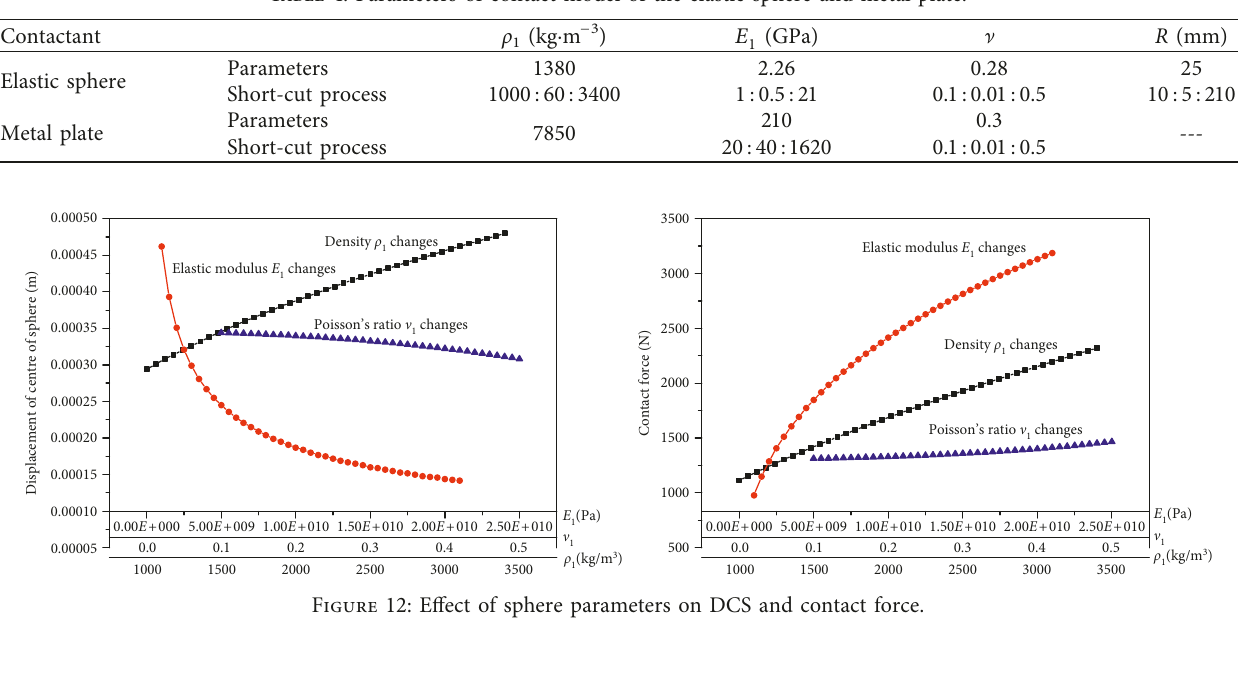
Table 4: Parameters of contact model of the elastic sphere and metal plate.